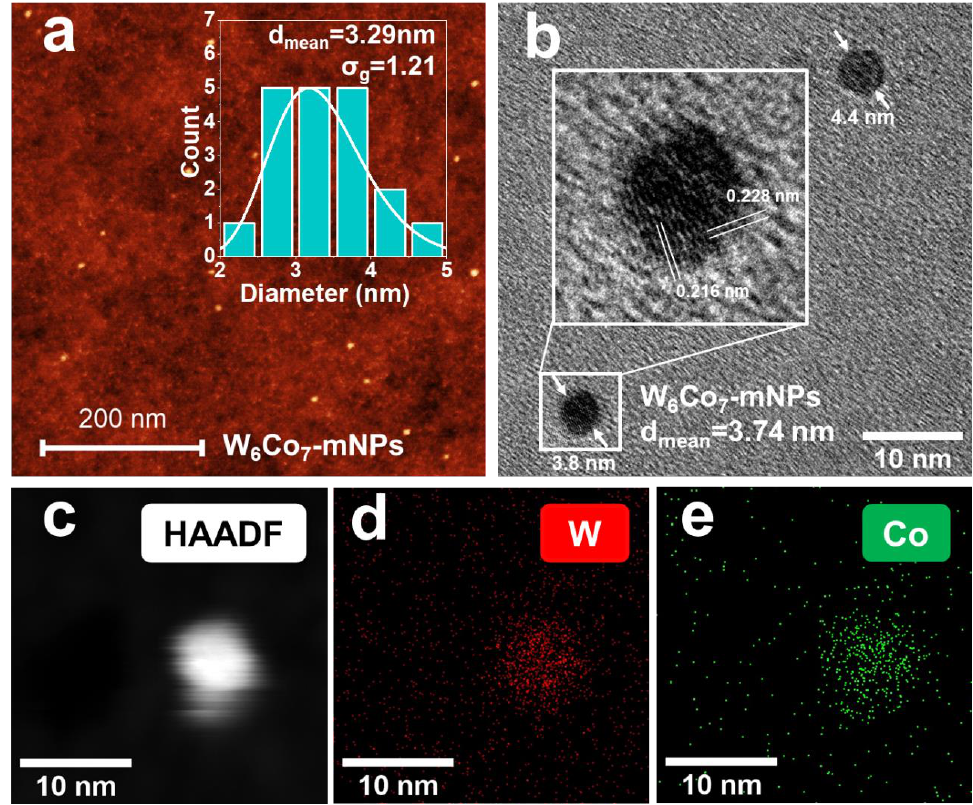
Figure 2. Nanoparticles after size selection and their crystal structure determination. ( a ) AFM images of size-selected W-Co salt nanoparticles (sNPs) homogeneously deposited on SiO 2 /Si substrates. Particle populations possessing narrow size distributions ( σ g = 1.21) with small mean diameters ( d mean = 3.29 nm) are shown in the inset histogram. Also shown is the HRTEM image ( b ) of single-crystal W-Co alloy metal nanoparticles (mNPs) after reduction and reconstruction. d mean = 3.74 nm measured by AFM is not shown. ( c – e ) With the energy-dispersive X-ray spectroscopy (EDS) elements mapping on single W-Co mNPs, ( c ) the scanning transmission electron microscopy (STEM) image acquired using the high-angle annular dark field (HAADF) detector is shown with the EDX spectra/maps on both ( d ) W and ( e ) Co. Both elements distribute uniformly across the single-crystal mNPs instead of the combination of multi-crystals. No accumulation of the oxygen element is seen in the area of NPs, verifying the alloy metal state of the NPs,